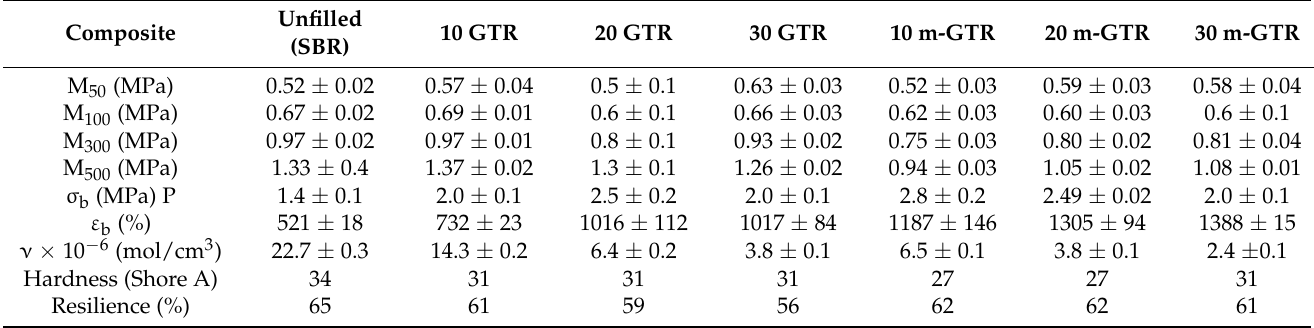
Table 6. Physico-mechanical properties of cryo-ground GTR-SBR and m-GTR-SBR